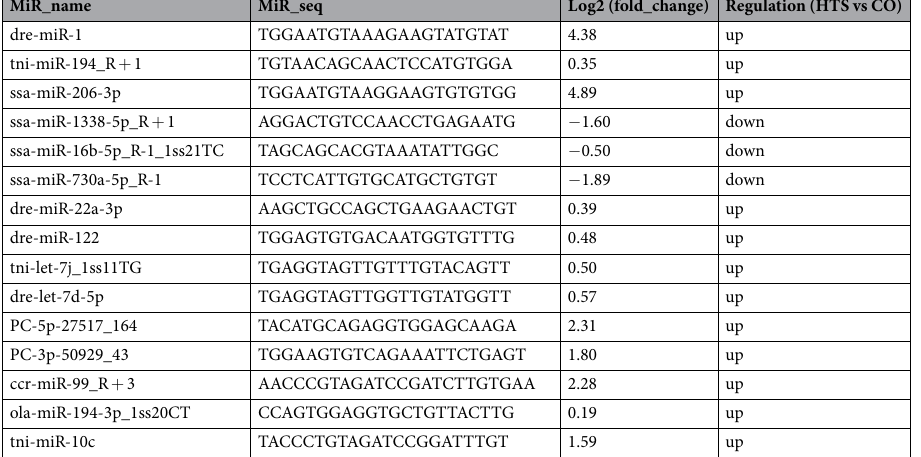
Table 3. The 15 differentially expressed miRNAs in heat-stressed GIFT liver verified by miRNA-Seq. Fold change = HTS group (mean)/CO group (mean), where “mean” is the mean of three biological